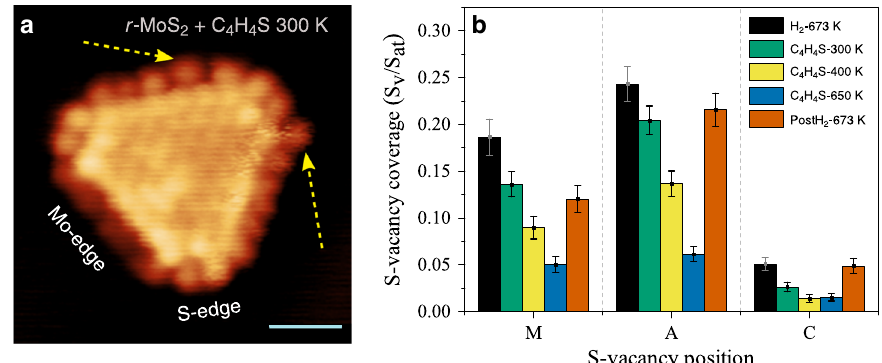
Fig. 3 Thiophene adsorption on MoS 2 -edges. a Atom-resolved STM image of a r -MoS 2 nanoparticle (Mo-6S edges), which was subsequently reacted with thiophene gas at room temperature (300 K). The superimposed arrows indicate the locations attributed to adsorbed thiophene. STM parameters: V t = − 0.22 V, I = − 0.40 nA. Scale bar is 1 nm. b Statistical plot showing the variation of the V t S fraction for each edge site position (M, A, and C) obtained by counting S vacancies in atom-resolved STM images, compiled from images with 4,5 and 6S atom positions on the Mo-edge. The data re fl ect a temperature series for the H 2 activated sample (black bins), and where thiophene is dosed at 300 K (green), 400 K (yellow), and 650 K (blue), respectively. The orange bins show the restored V S vacancy distribution after post-reacting the thiophene-exposed sample in H 2 at 673 K. A statistical breakdown for each edge length is provided in Supplementary Fig. 2. Error bars re fl ect the statistical uncertainty based on the standard